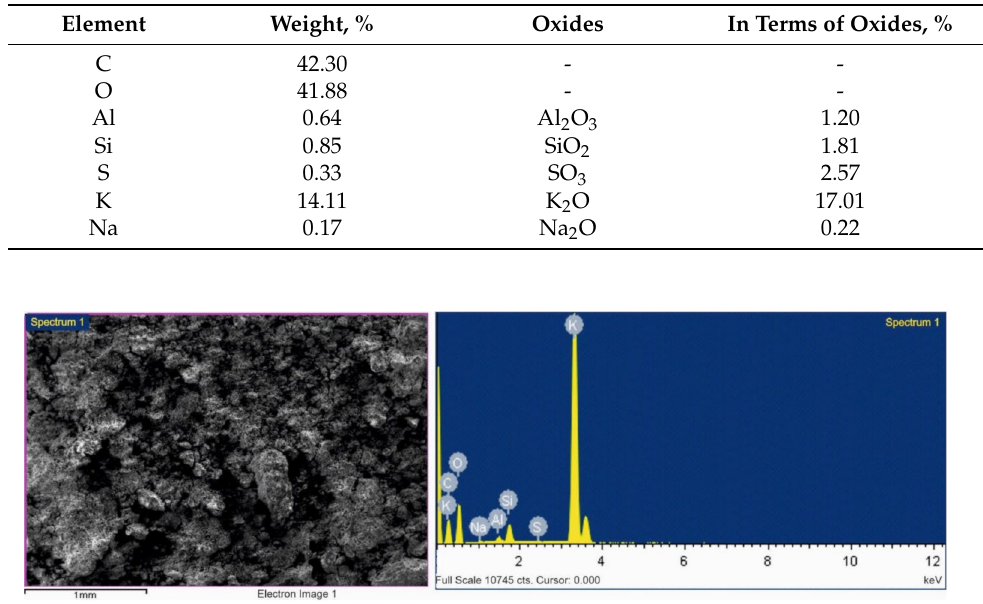
Figure 9. Microstructure of potassium humate extracted from coal mining